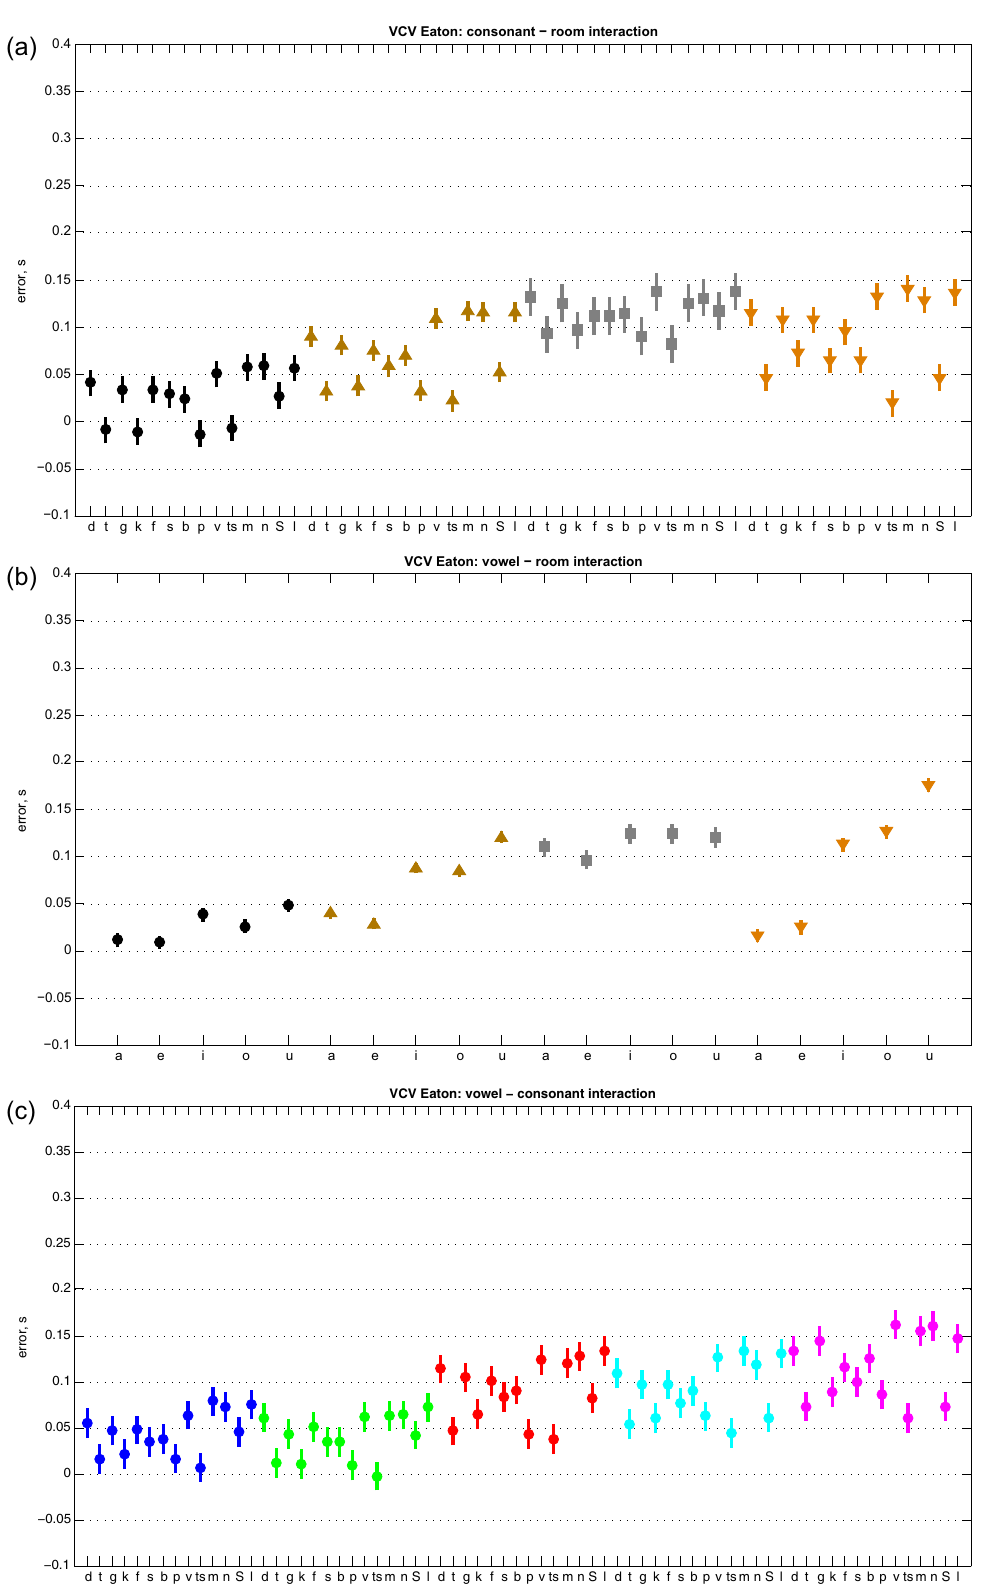
Figure 4. VCV logatomes: marginal means for Eaton ’ s algorithm. (a) “ Consonant ” (cid:5) “ room ” interaction, (b) “ vowel ” (cid:5) “ room ” interaction, (c) “ vowel ” (cid:5) “ consonant ” interaction. X -axis details: For the panels (a) and (c) central consonants of the VCVs are denoted on the x -axis. For the panel (b) vowels (/a/, / ɛ /, / ɪ /, /c/, / f /) as “ a ”–“ u ” . Symbols for the marginal means: For the panels (a) and (b) “ booth ” – circle, “ meeting ” – upward triangle, “ listening ” – square, “ of fi ce ” – downward triangle. For the panel (c) vowels (/a/, / ɛ /, / ɪ /, /c/, / f